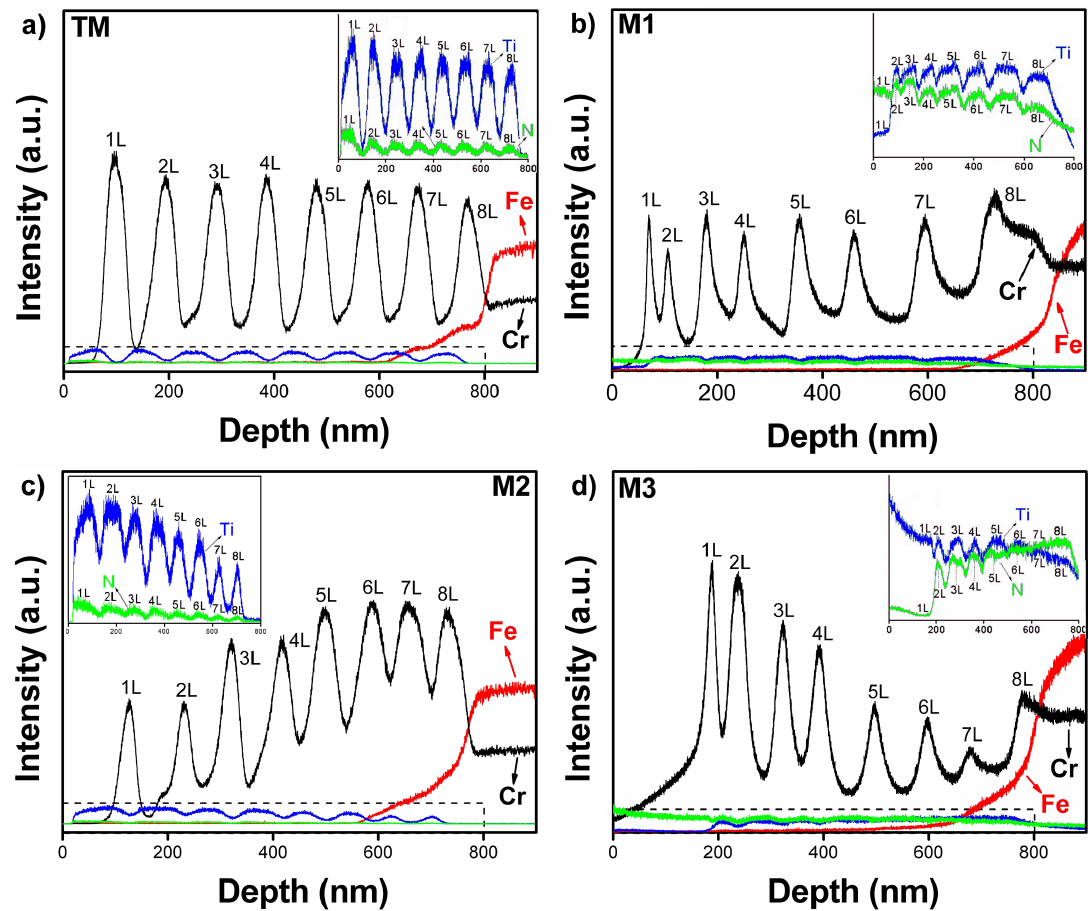
Figure 4. GD-OES profiles of TiN/Cr multilayers (a) TM, (b) M1, (c) M2 and (d) M3. Ti and N signals are evidenced in